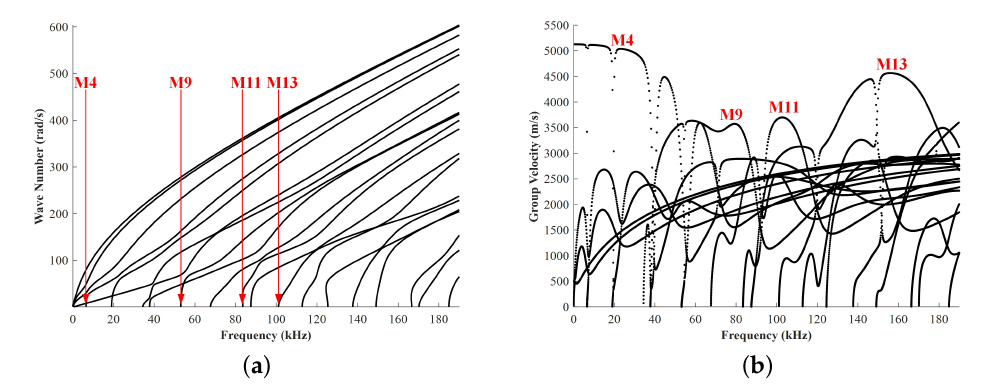
Figure 3. Dispersion curves for waves propagating in a L-bar: ( a ) wave number, ( b ) group velocity.